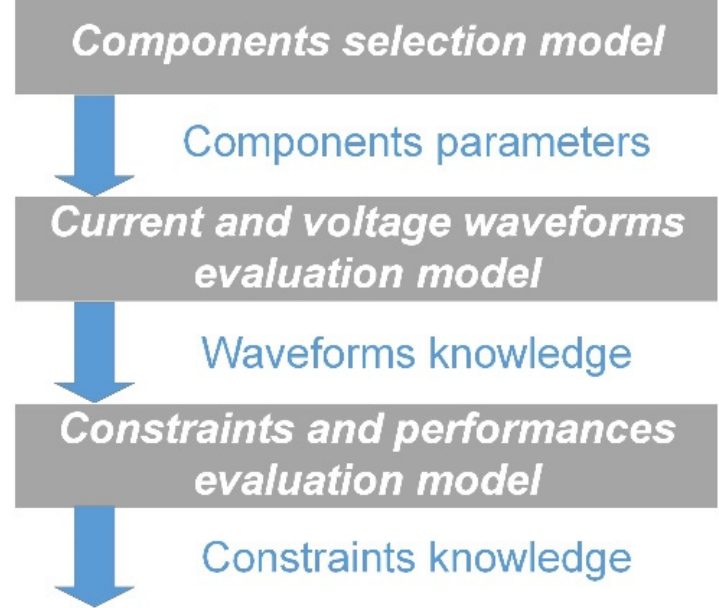
Figure 6. Power electronics sub-system models preferred organization for the proposed approach.